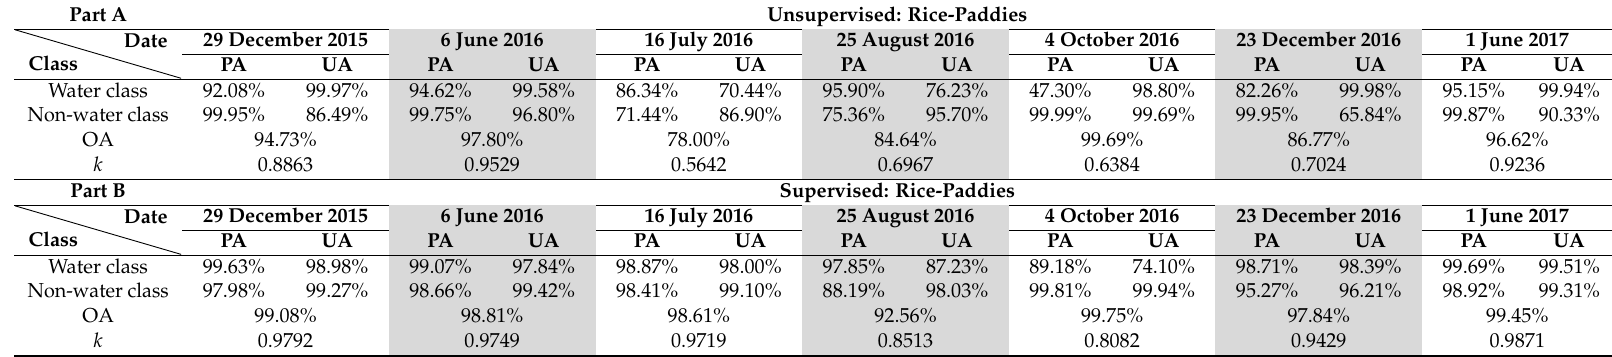
Table 6. Part A and Part B show for the rice-paddies the accuracy assessment results for the unsupervised and supervised approaches, respectively.